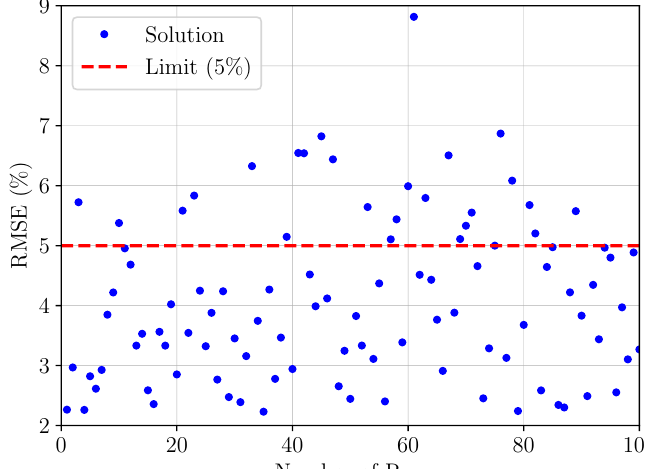
Figure 11. Achieved RMSE.